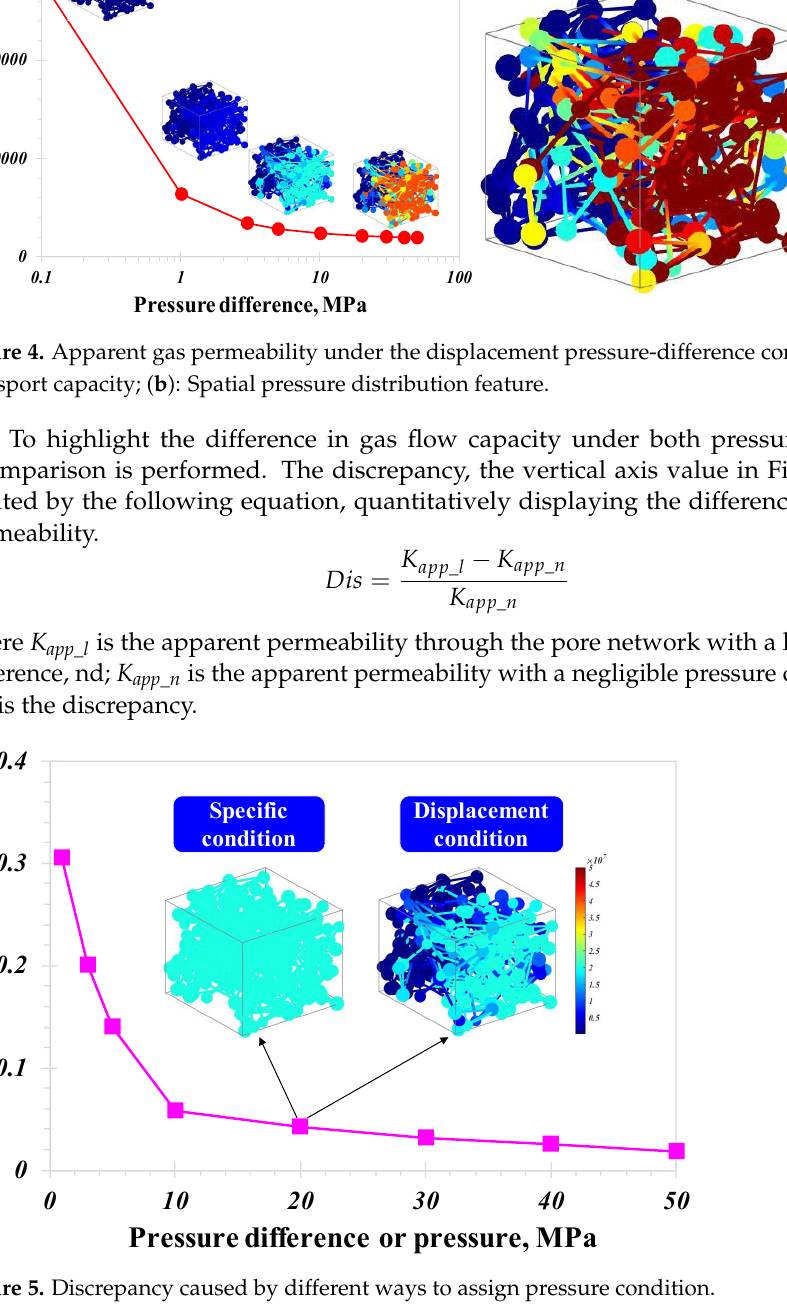
Figure 5. Discrepancy caused by different ways to assign pressure condition.